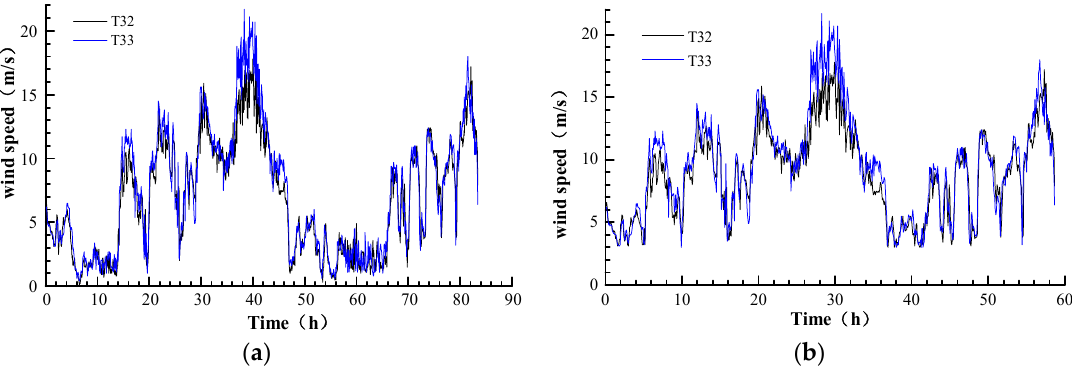
Figure 4. Original wind speed data and cleaned wind speed data; ( a ) original data; ( b ) cleaned and sorted data.